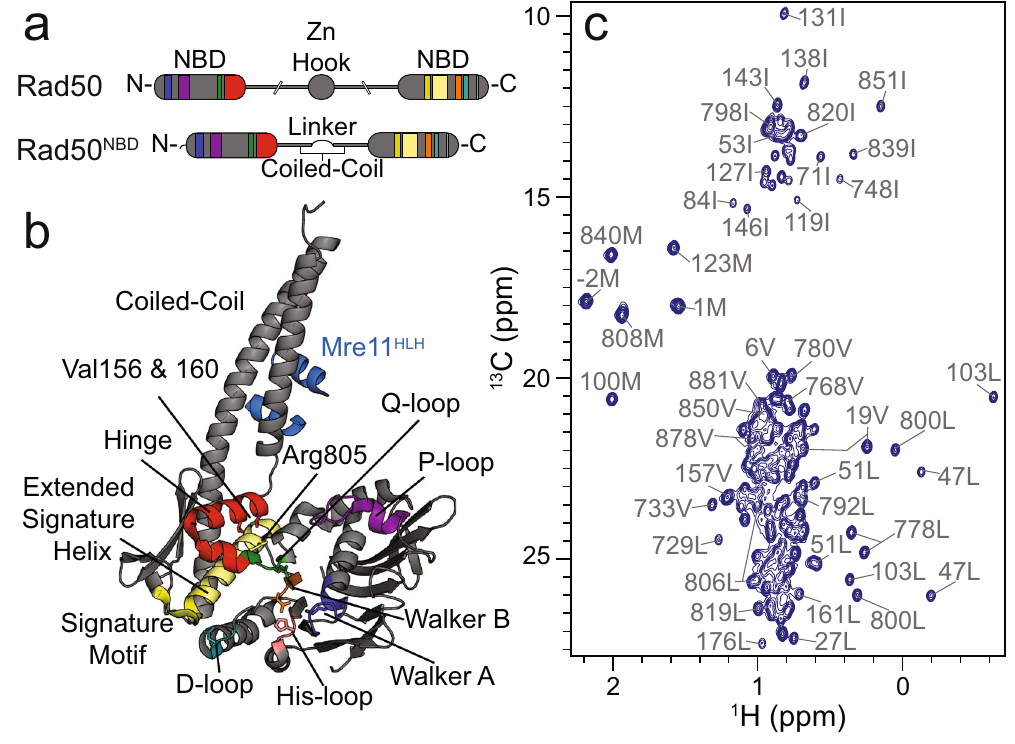
Figure 1. Domain architecture and NMR spectra of Rad50. ( a ) Cartoon representation of full length Rad50 (top) and Rad50 NBD (bottom). ( b ) Crystal structure of P. furiosus Mre11 HLH -Rad50 NBD (3QKS) 18 . Colors in ( a ) and ( b ) illustrate conserved domains important for Rad50 function. ( c ) 2D 13 C, 1 H methyl-TROSY HMQC 25 spectrum of Mre11 HLH -Rad50 NBD collected at 14.1 T and 50 °C. The side chain methyl group assignments are